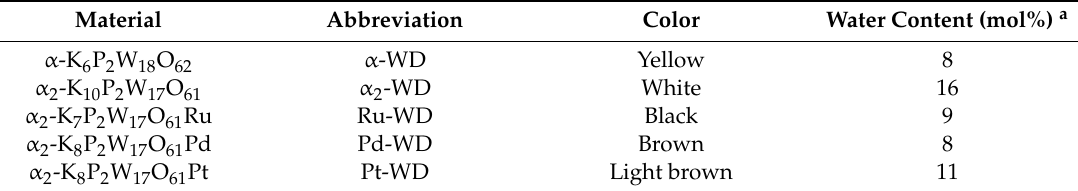
Table 3. Overview of prepared